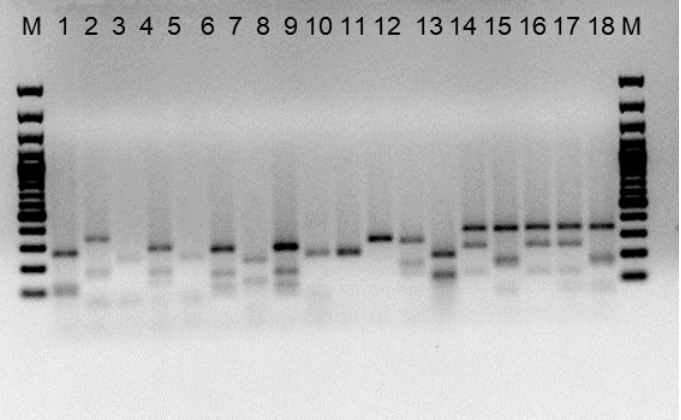
Figure 3. Agarose gel electrophoresis of HinfI restriction profiles (18 colonies out of 62). M: molec- ular marker, 100 bp ladder (Fermentas). marker, 100 bp ladder